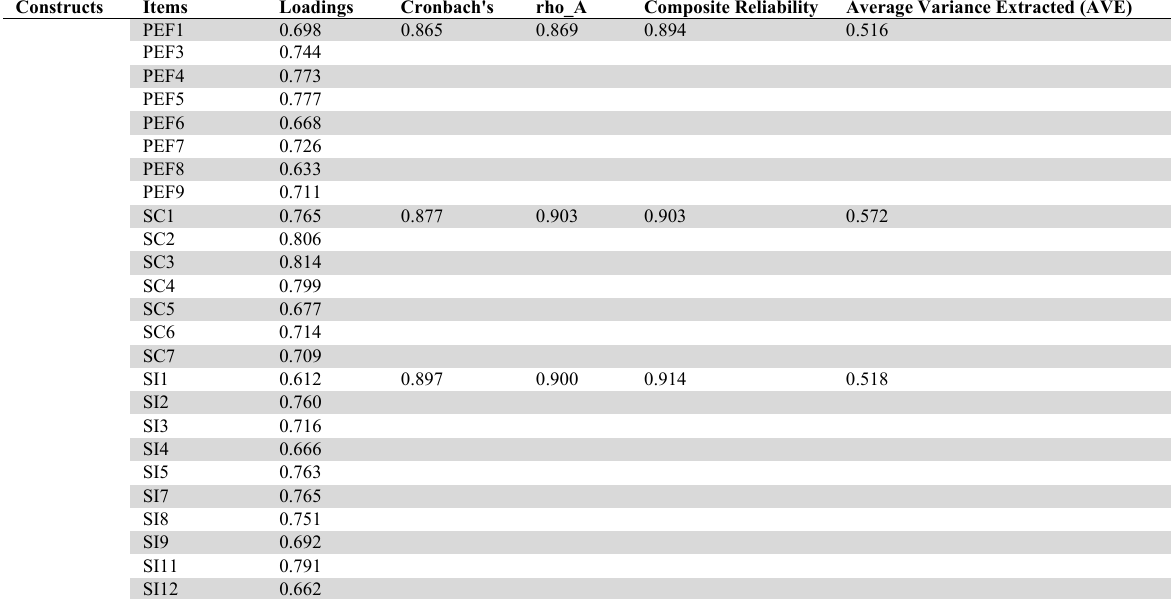
Loadings, Composite Reliability and Average Variance Extracted Constructs